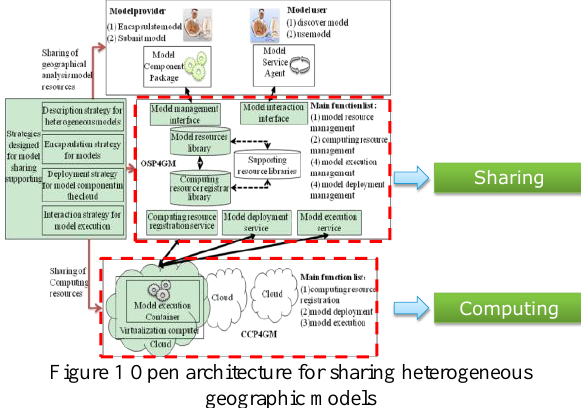
Figure 1 Open architecture for sharing heterogeneous geographic models